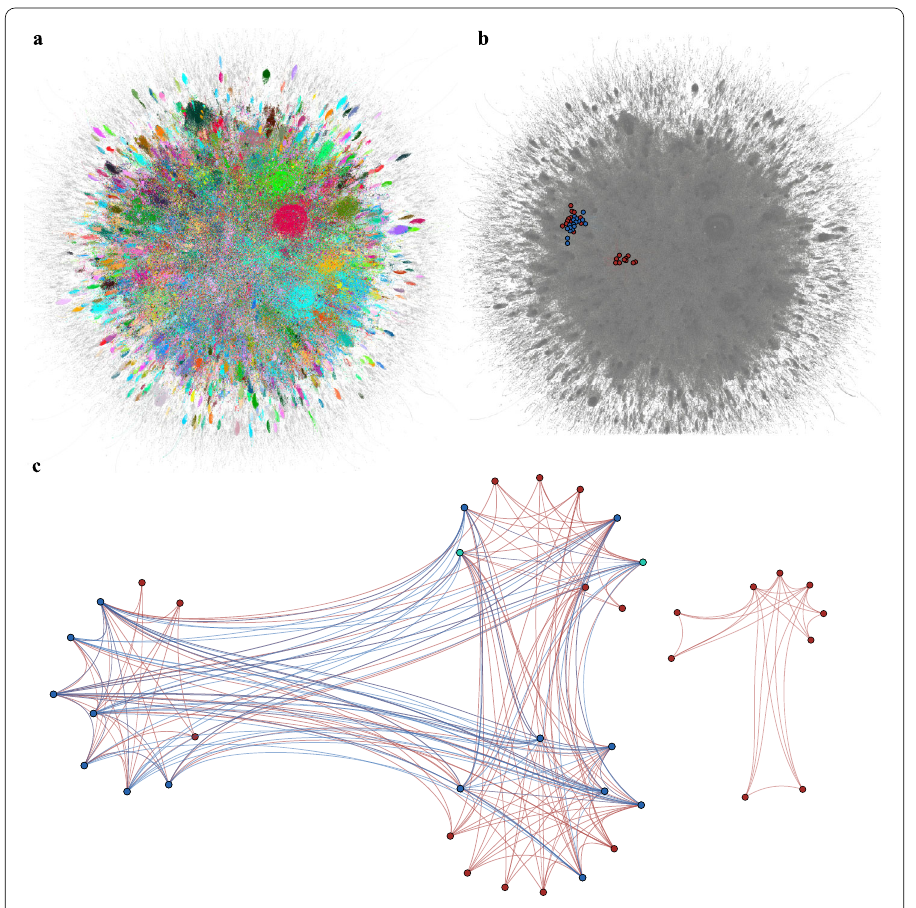
Figure 3 Reduced k -Cliques and Emerging Suspicious Groups in the Panama Papers Network.( a ) Communities in the Panama Papers network. ( b ) Position of suspicious nodes in the network (zoom). ( c ) Simultaneous representation of all 5-cliques of the reduced network. Red nodes correspond to those that are also part of the reduced 6-cliques found in the network. Notice that here and in the accompanying figures, the 5 and 6-cliques are connected between themselves in the reduced network (i.e., they are not independent) and the figure shows all the connections between those nodes, hence there